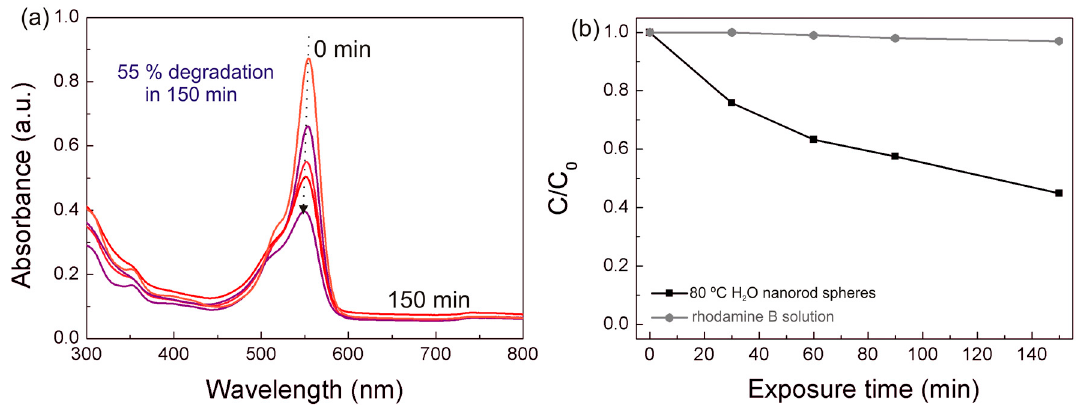
Figure 8. ( a ) Rhodamine B absorbance spectra at different solar light exposure times for the 80 °C H 2 O nanorod spheres. ( b ) Rhodamine B degradation ratio ( C / C 0 ) vs. solar light exposure time. The blank rhodamine B solution was simultaneously exposed during the degradation